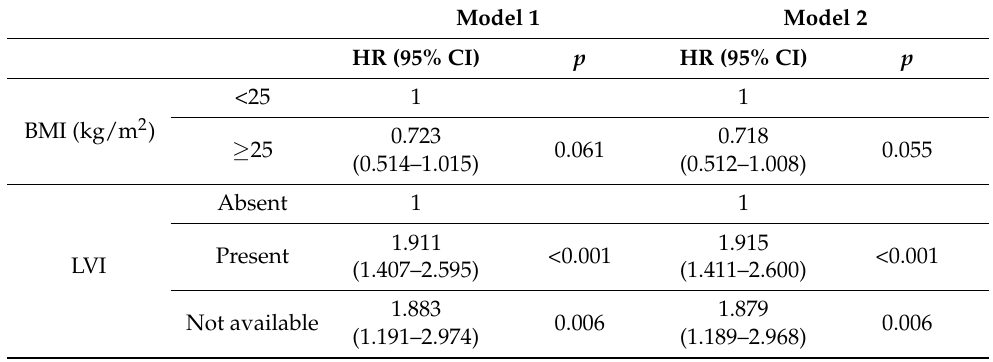
Table 3. Multivariate analysis of factors associated with progression-free